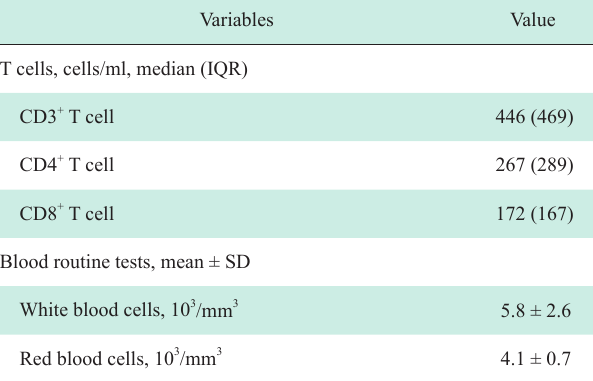
Table 2 Laboratory tests in 27 COVID-19